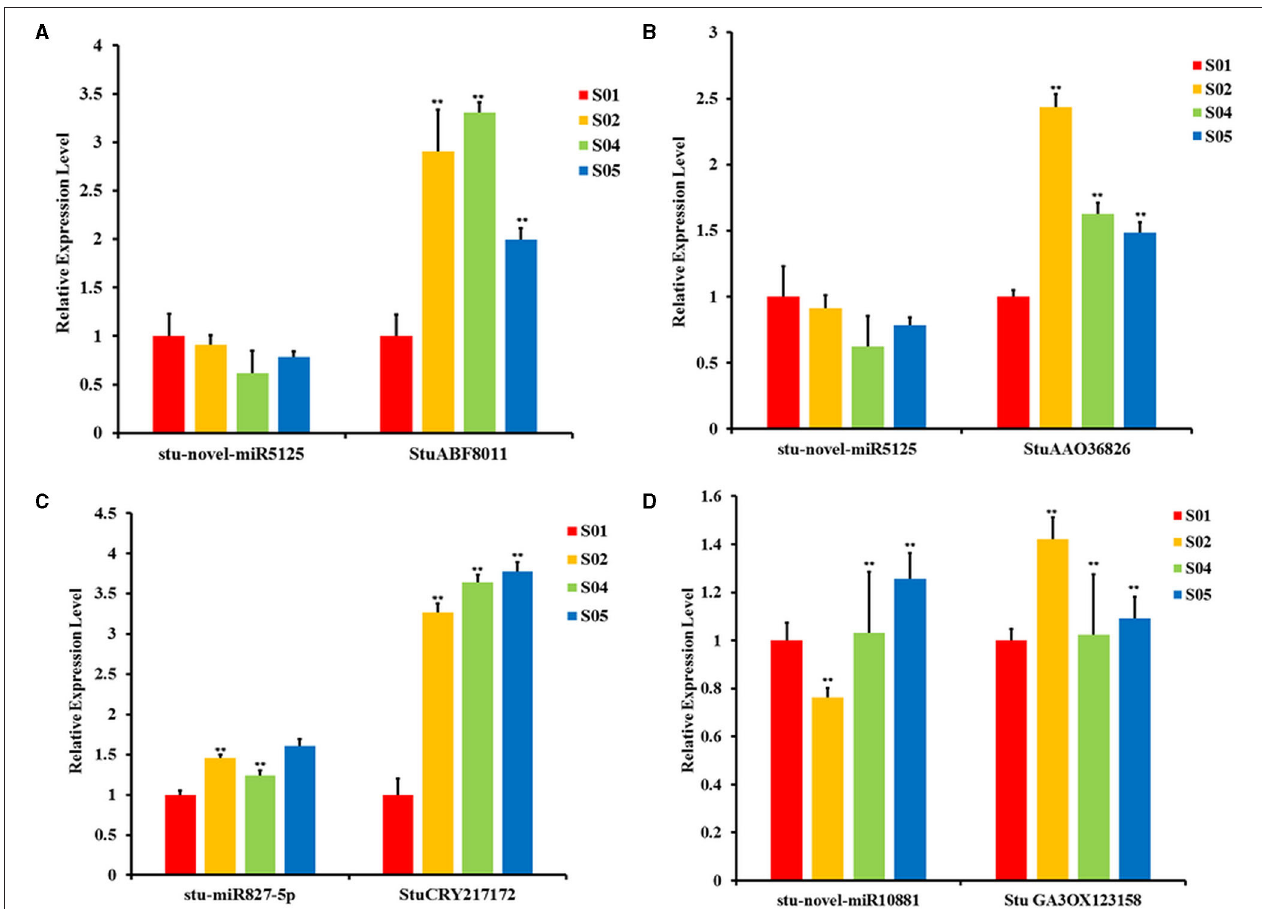
FIGURE 7 | The qRT-PCR validation of partial miRNAs and the target genes during cold stress in the potato. (A,B) The expression patterns of the stu-novel-miR5125 was opposite to the related target genes; (C) The expression patterns of the stu-miR827-5p and its target gene; (D) The expression patterns of the stu-novel-miR10881 was opposite to the related target gene. * P < 0.05; ** P < 0.01; the number of biological replicates =